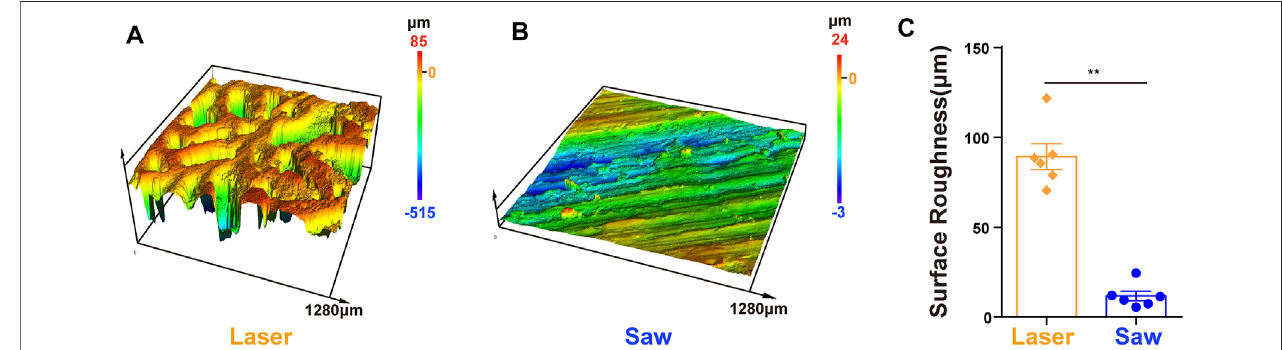
FIGURE 4 | Surface roughness. (A,B) 3D height distribution images of the bone surface which were taken with the laser confocal scanning microscope after laser and mechanical saw cutting. (C) Surface roughness, **, p <